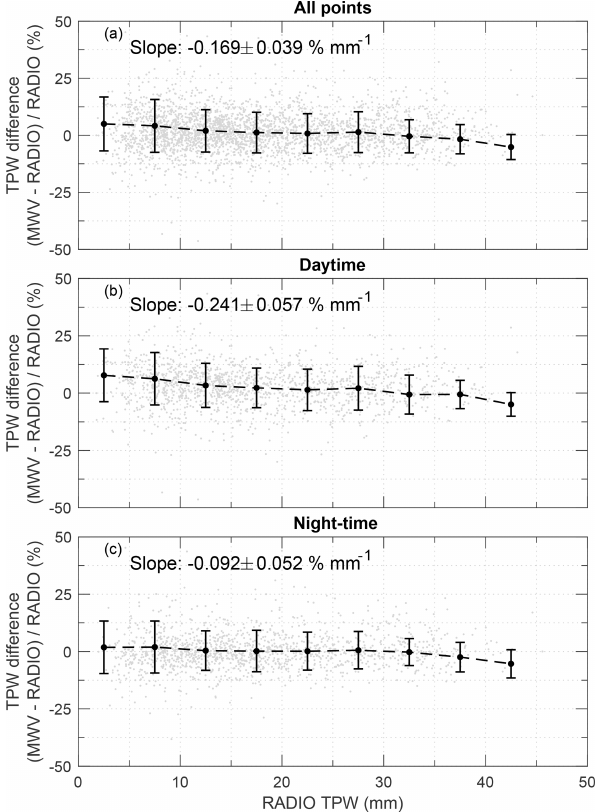
Figure 8. Dependence plot of the relative difference of the TPW from the microwave radiometer and the radiosondes from the total amount of TPW for (a) all points, (b) the daytime measurements and (c) the night-time measurements. The black dots show the av- erage difference in bins of 5mm and the error bars represent their standard deviation. The linear fit is based on all